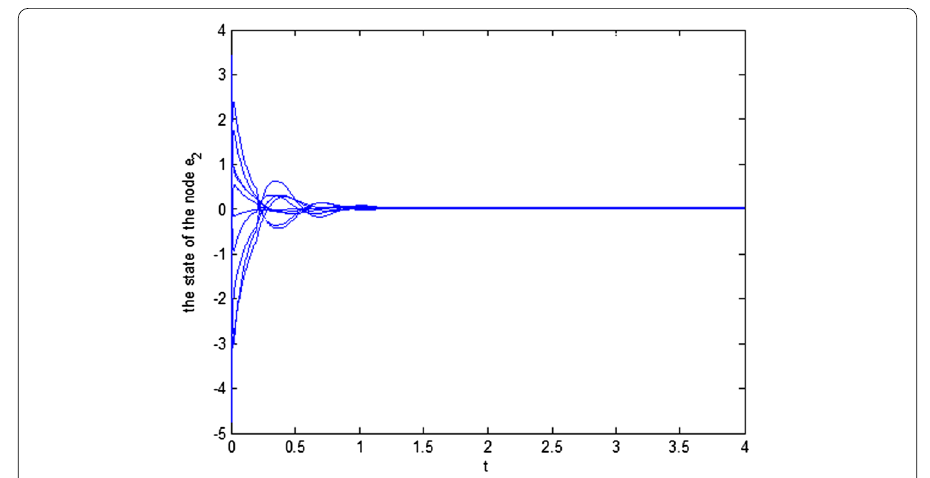
Figure 5 The state of the node e 2 with controller